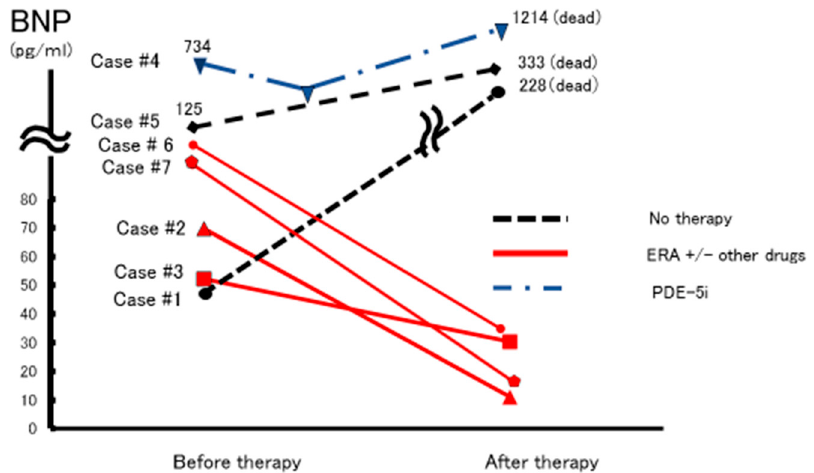
Figure 2. Changes in serum BNP levels in seven patients with PoPH. In patients #2, #3, #6, and #7, the serum BNP levels were decreased after therapy. Combination therapy (ERA and PDE5i or PRA) in patients #2, #6, and #7 and ERA in patient #3 were effective. In patient #4, PDE-5i monotherapy was ineffective and the patient died. In patients with PoPH who did not receive therapeutic drugs (Cases #1 and #6), serum BNP levels increased and the patients died. BNP, brain natriuretic peptide; ERA, endothelin receptor antagonists; PDE-5i, phosphodiesterase-5 inhibitor; PRA, prostacyclin receptor agonist.